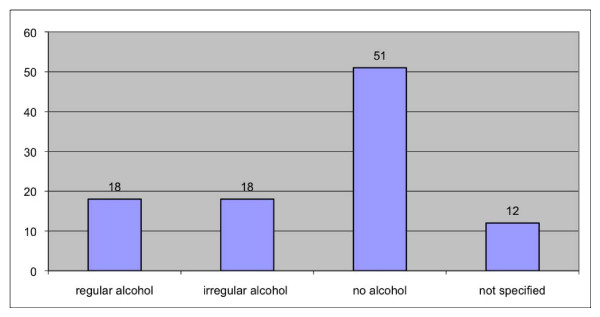
Risk factor alcohol.